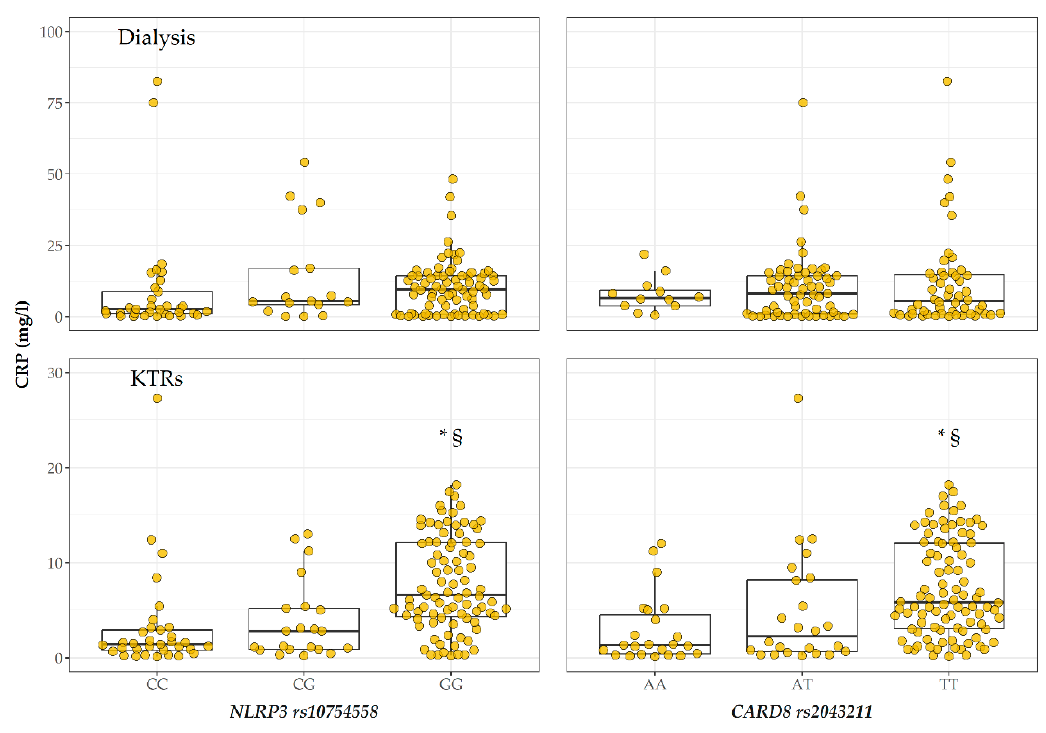
Figure 1. CRP levels by rs10754558 and rs2043211 genotype in Dialysis (upper panels) and KTRs (lower panels) patients. * p < 0.05 vs. CC/AA; § p < 0.05 vs. CG/AT.